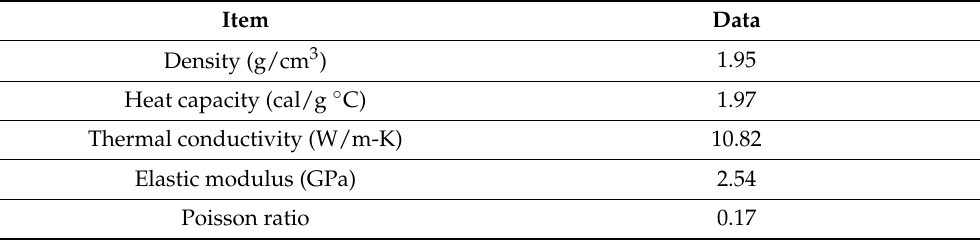
Figure 5. Description of molding simulation conditions: ( a ) configuration of the injection mold, ( b ) finite-element mesh, ( c ) viscosity chart, and ( d ) PVT diagram of the molding material. Table 2. Material properties of injection mold.